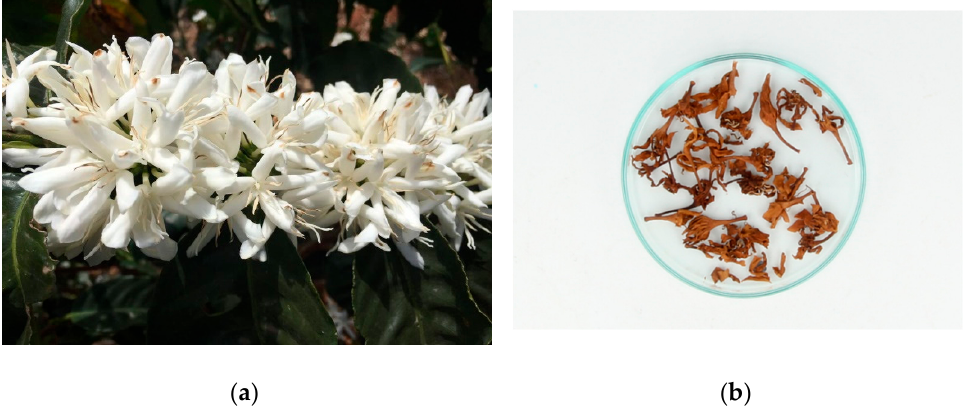
Figure 1. Coffee flowers ( a ) on the tree during the short flowering period, and ( b ) in the air-dried state similar to the samples analyzed in this study.